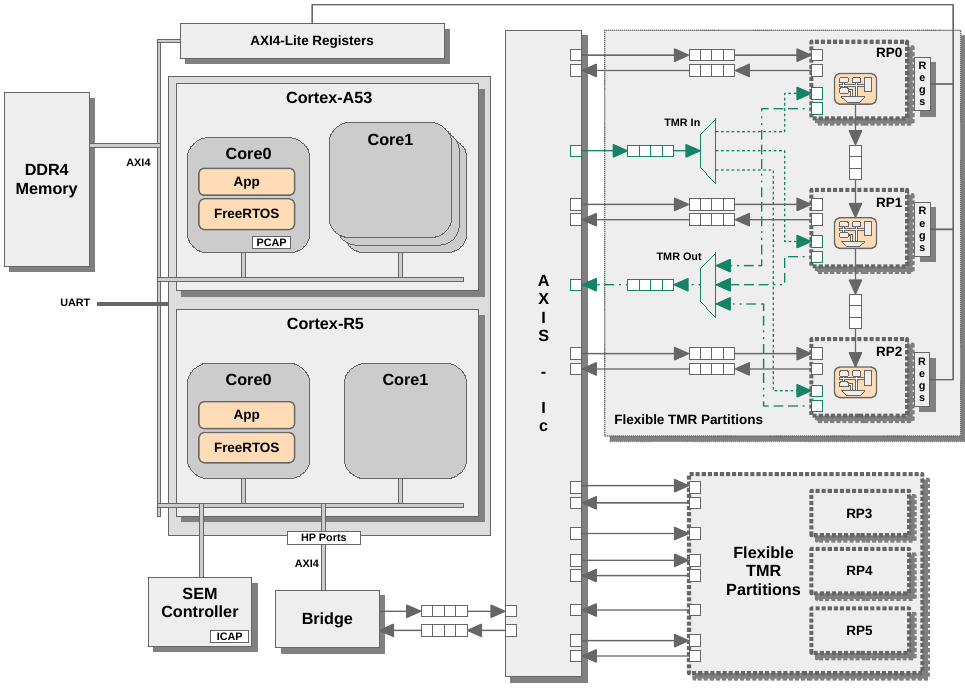
Figure 2. Payload Board